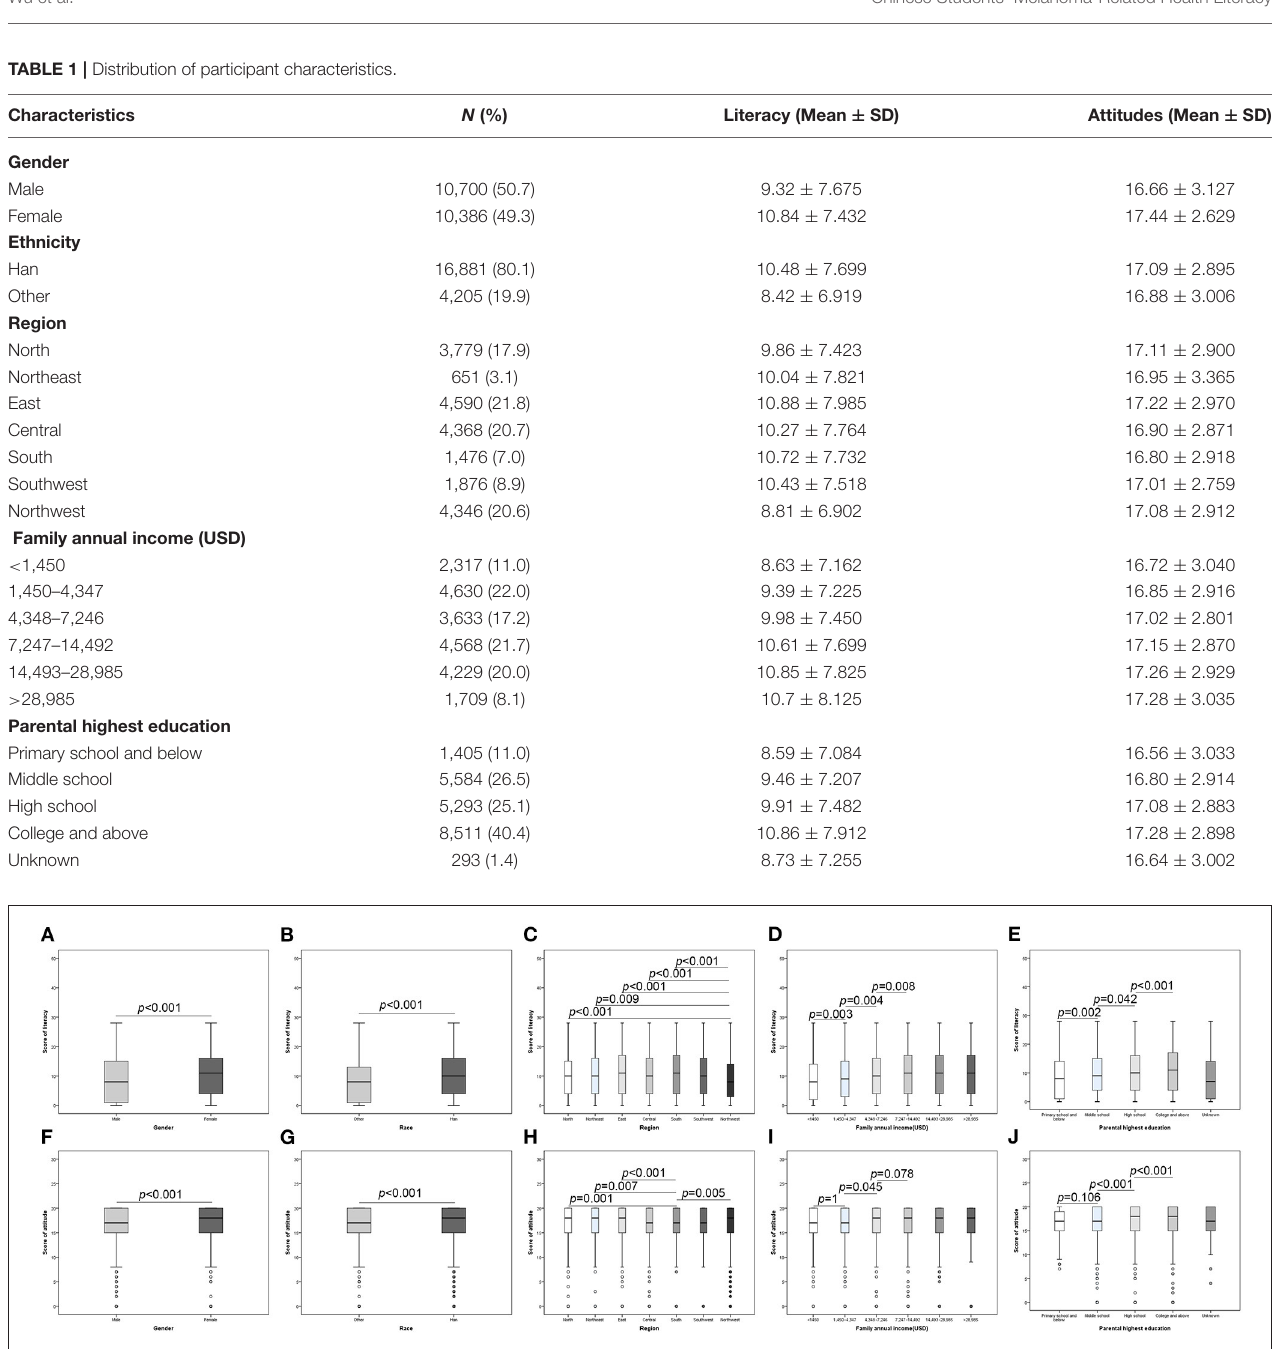
FIGURE 2 | Association between literacy (attitudes) and participant characteristics. (A) Health literacy between different gender; (B) Health literacy between different races; (C) Health literacy between different regions; (D) Health literacy between different family annual income; (E) Health literacy between different races; (F) Attitudes between different gender; (G) Attitudes between different races; (H) Attitudes between different regions; (I) Attitudes between different family annual income; (J) Attitudes between different